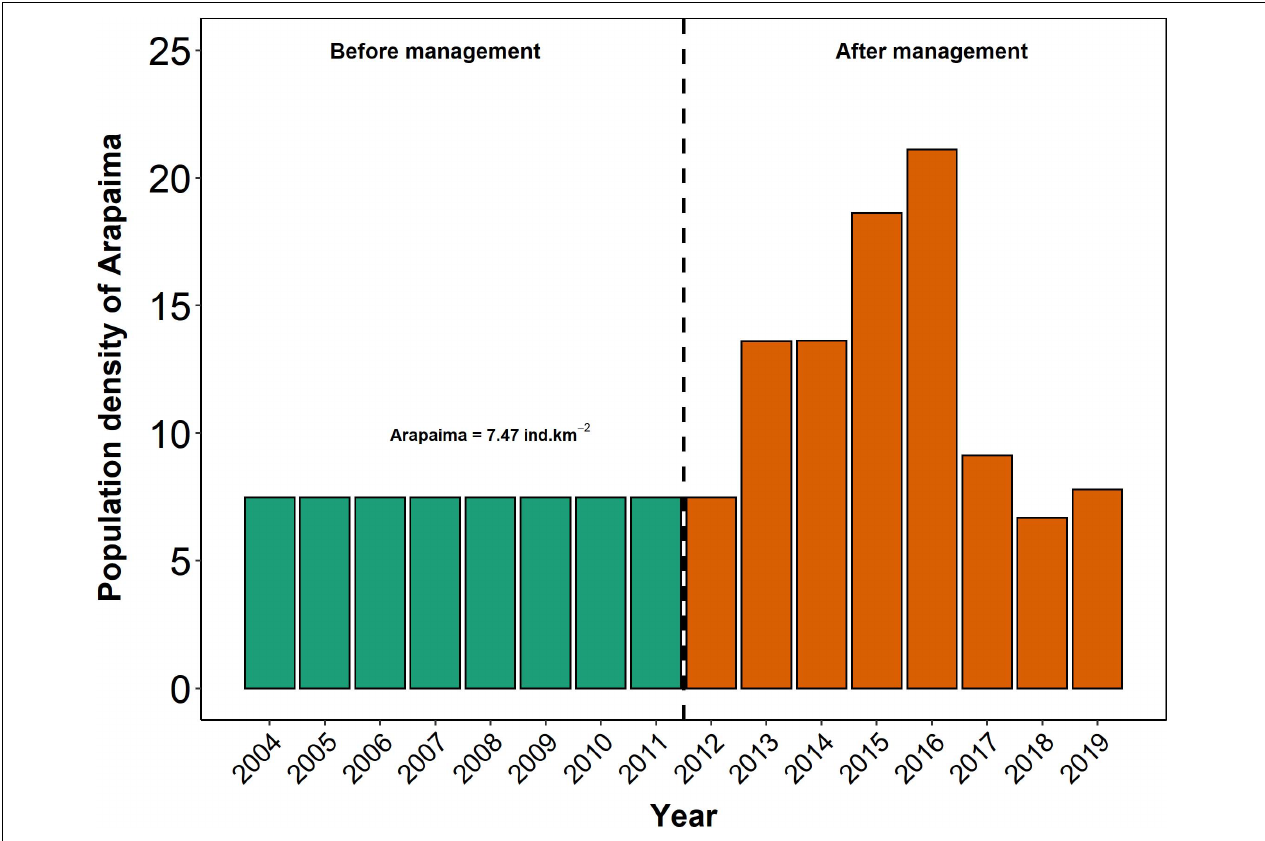
FIGURE 2 | Time-series data on population density of Arapaima sp. based by counts ( > 1 m total length) in Paciência Island. Density data shown for 2004–2011 are estimated based on the assumption that they are identical to that for 2012, first year with annual